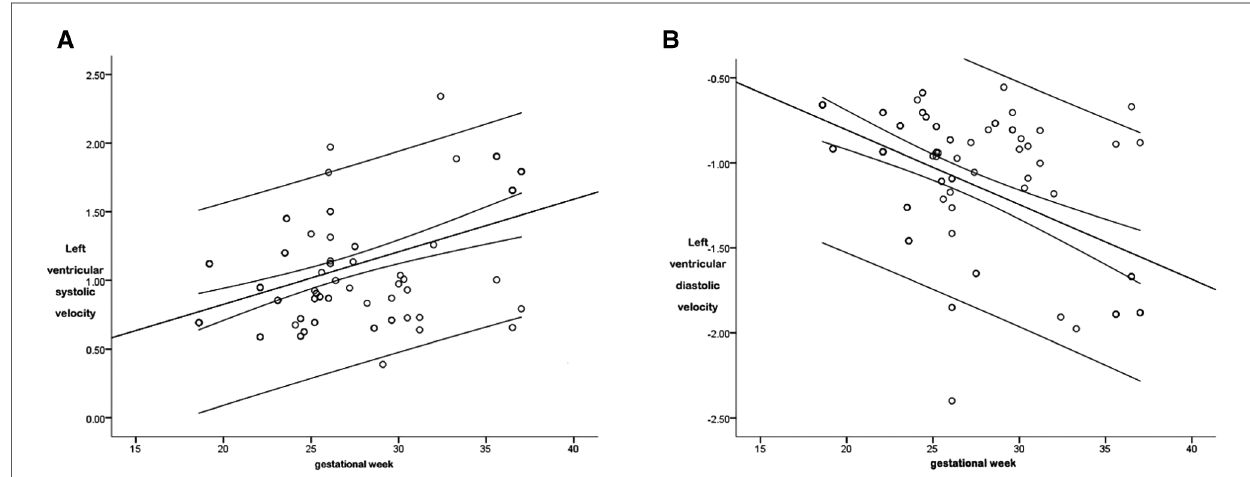
FIGURE 5 The scatter diagram of the relationship between the global left ventricular systolic ( A ) and diastolic ( B ) peak velocity and gestational age. As is shown in Figure 5A , there was a correlation between the left ventricular global systolic peak velocity and the gestational age ( P <0.05), with a correlation coef fi cient r =0.497, and the regression equation was calculated as follows: global left ventricular systolic velocity=0.061+(0.038×gestational age). As is shown in Figure 5B , there was a correlation between the left ventricular global diastolic peak velocity and the gestational age ( P <0.05), with a correlation coef fi cient r =0.557, and the regression equation was calculated as follows: left ventricular global diastolic velocity=0.072+( − 0.044×gestational